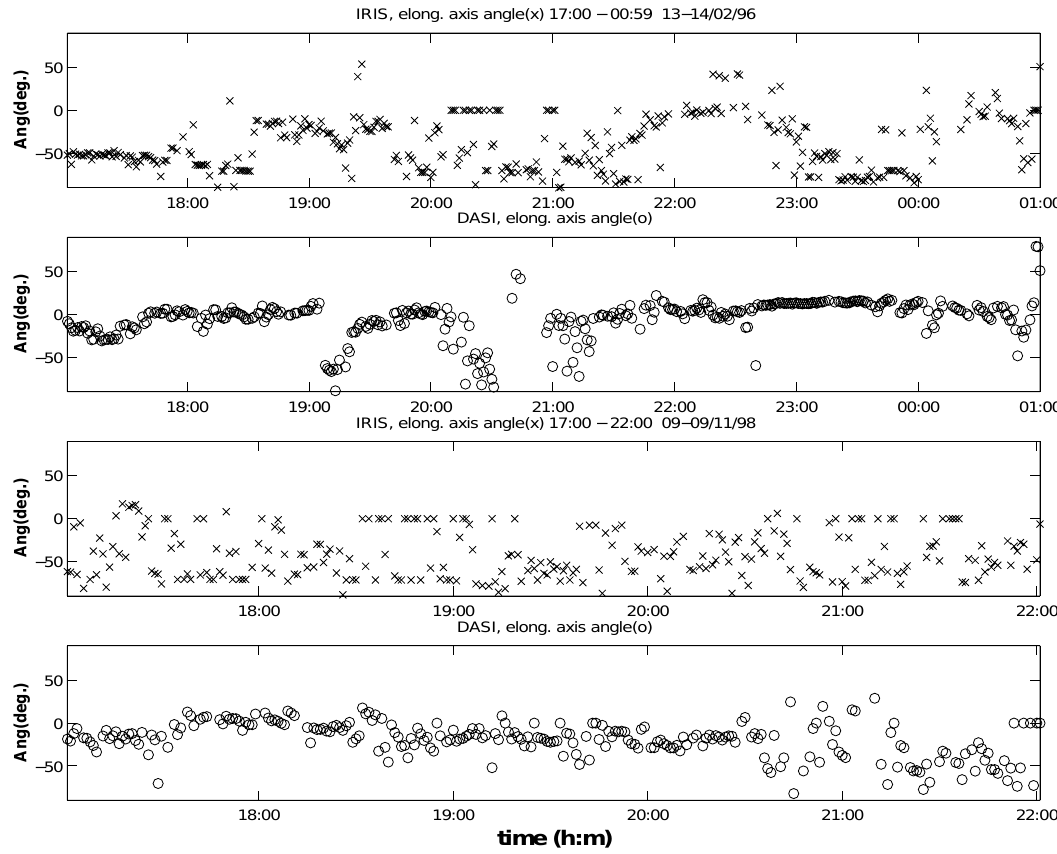
Fig. 9. Angle between the geographic east-west direction and the main axis of the closed contours of maximum length at any given time for both IRIS (x) and DASI (o). Angles for period 13–14 February 1996 are shown in the first and second panels from the top, and in the third and four panels for 9 November 1998. The main axes are in most cases within ± 50 ◦ from the east-west